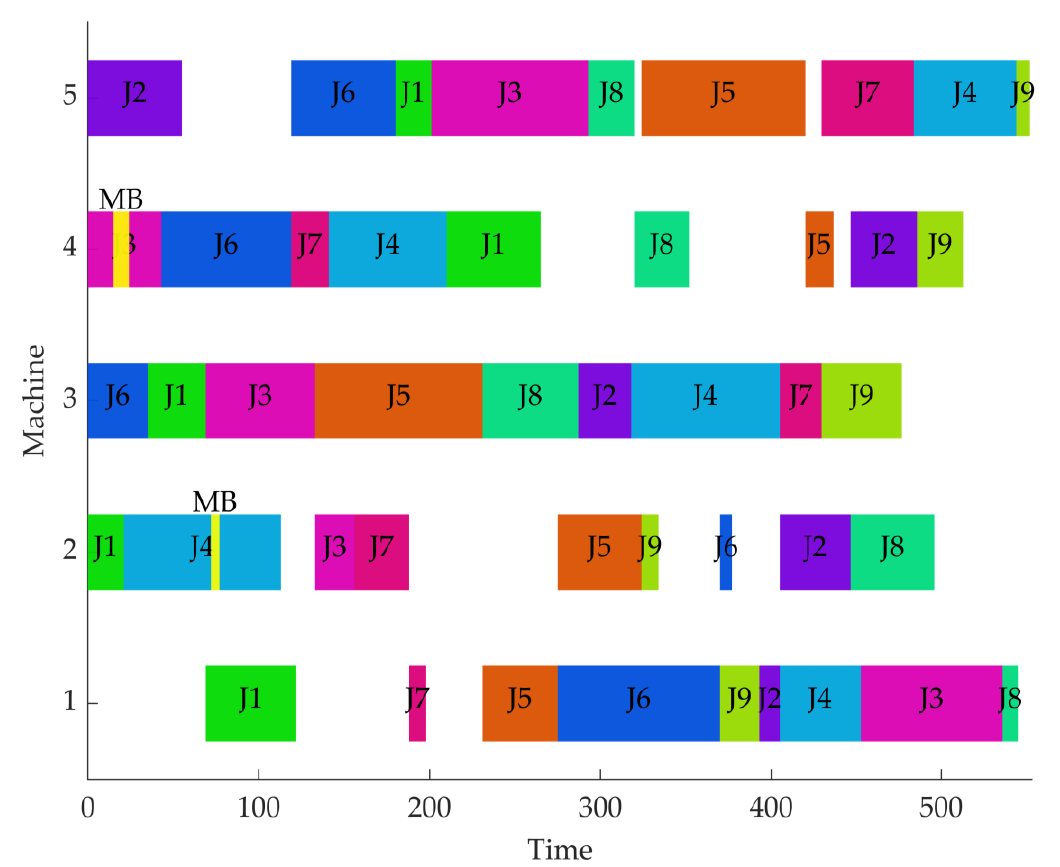
Figure 8. The Gantt chart of the 6 × 5 DJSSP with IHKA VonNeumann. Table 4. The computational statistics of the IHKA and HKA on the fitness for the benchmark instances of DJSSP. Size